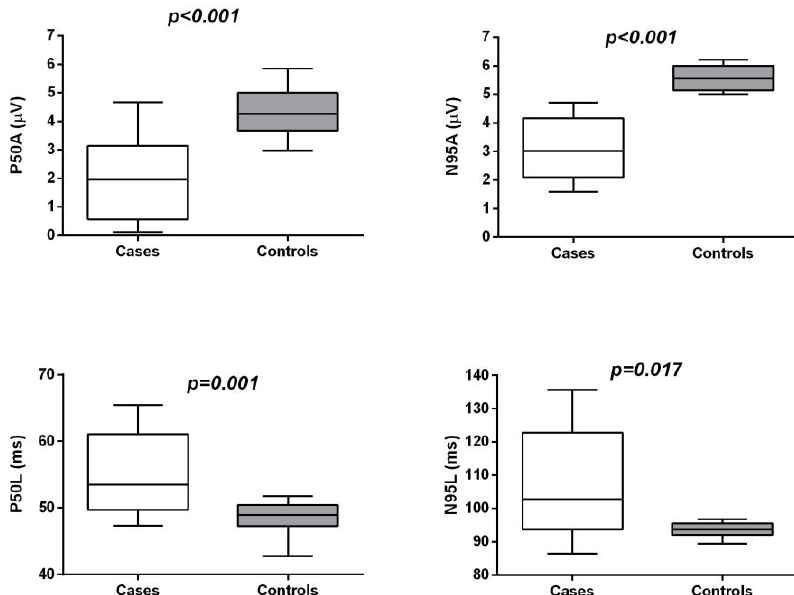
Figure 1 . Box – whiskers graphs of functional parameters. Box – whiskers plots show the 25th and 75th percentiles (box) with 95% Tukey confidence intervals (whiskers) and median values (transverse lines in the box). p -values in the figure are derived from the Mann – Whitney U test.